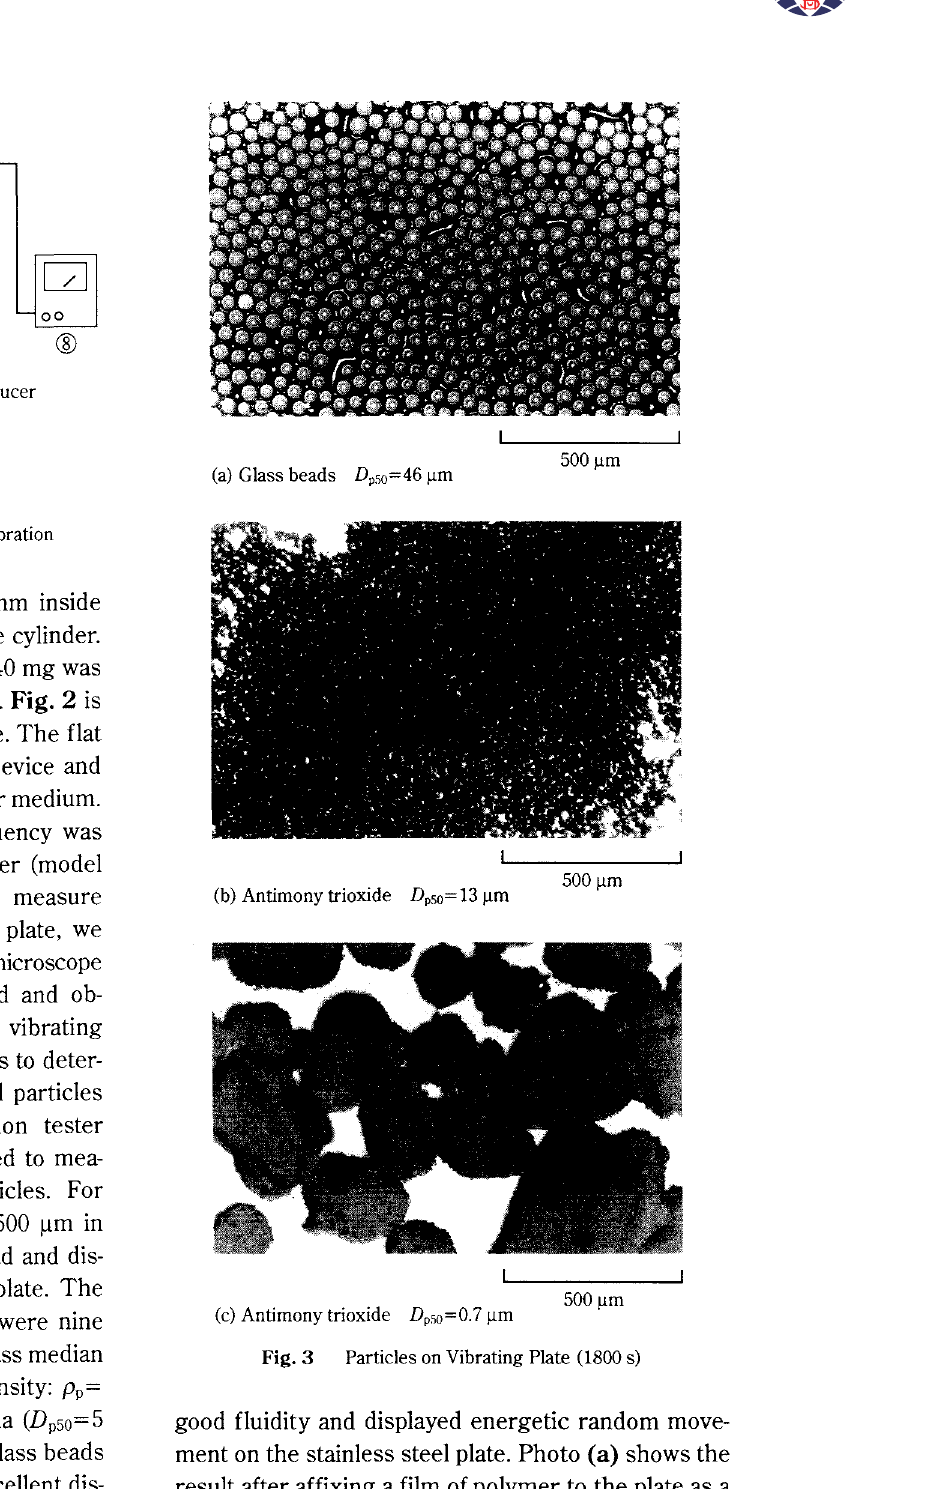
Fig. 2 Experimental Apparatus for Particle Vibration plate stainless steel container with a 92 mm inside diameter placed at the bottom center of the cylinder.